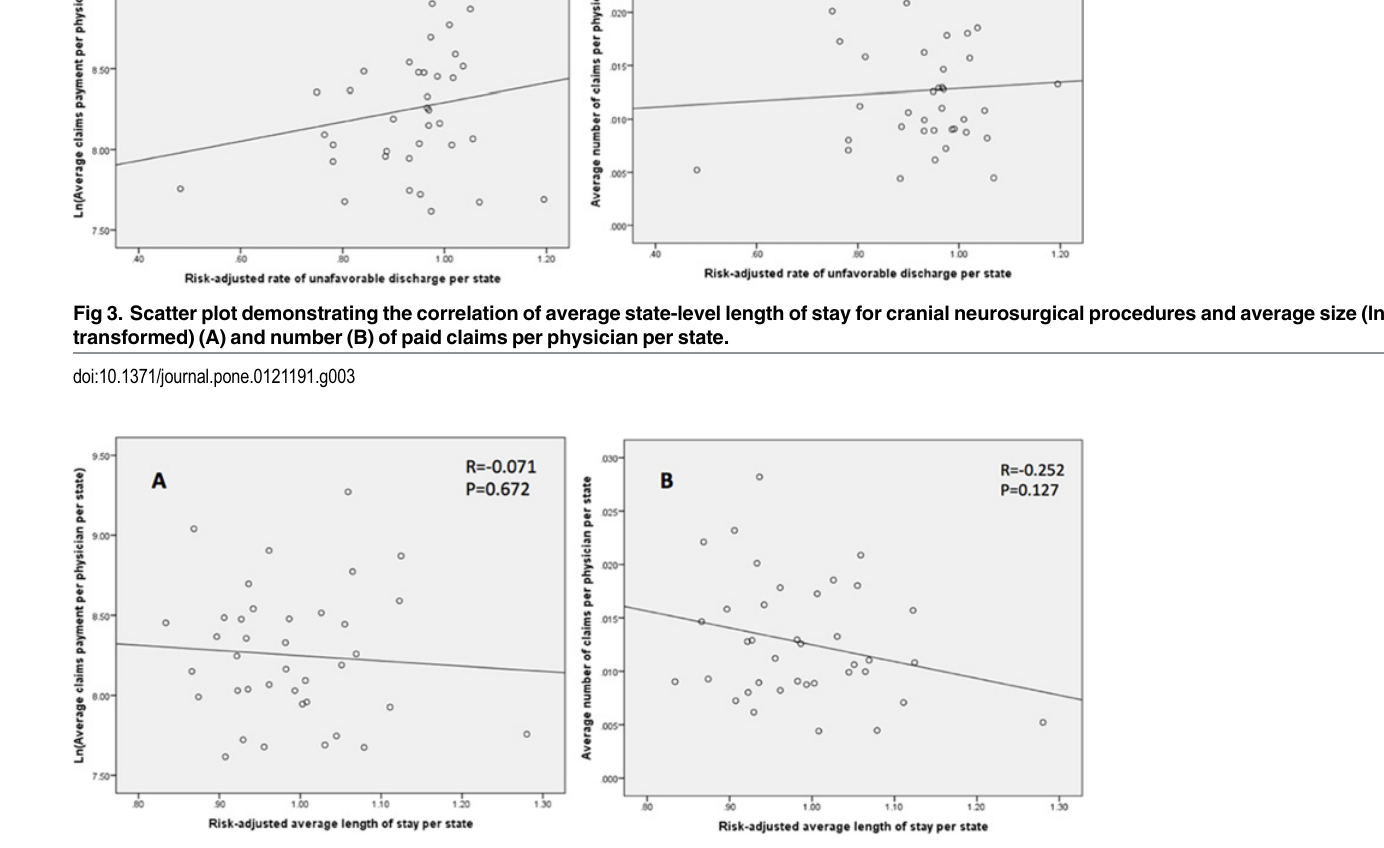
Fig 4. Scatter plot demonstrating the correlation of the rate of unfavorable discharge after cranial neurosurgical procedures and average size (ln- transformed) (A) and number (B) of paid claims per physician per state.